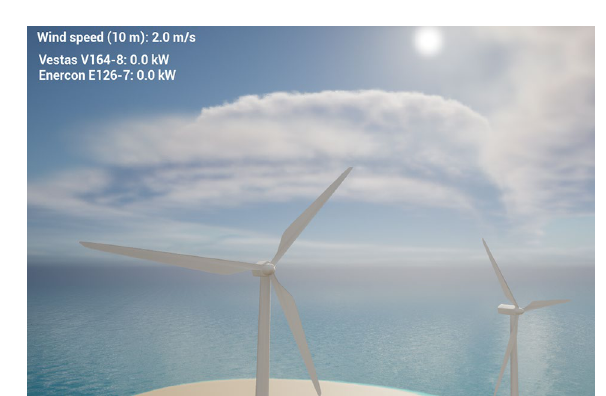
Fig. 21 Screenshot of the output at Scenario